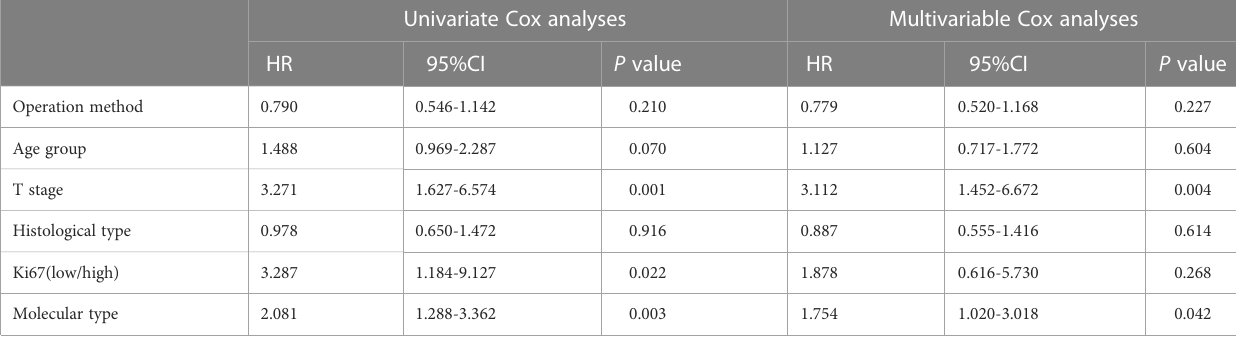
TABLE 5 Univariate and Multivariable Cox analyses of operation method and other clinical characteristics on BCSD. Univariate Cox analyses Multivariable Cox